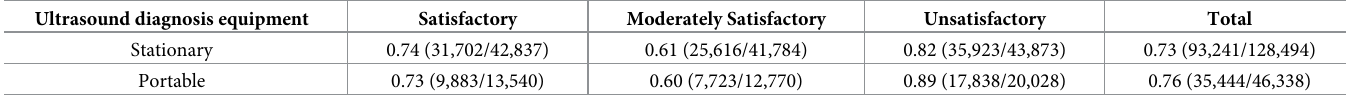
Table 5. Classification accuracy using the learned model.